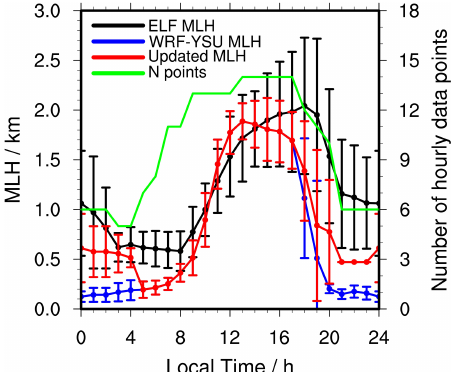
Figure 6. ELF-observed and model-simulated diurnal variations in MLH at the UMBC site during the Discover-AQ campaign. “ELF MLH” denotes ELF-derived MLHs by using the covariance wavelet transform method. “WRF-YSU MLH” denotes the 36km WRF- YSU k zz -determined MLHs, and “Updated MLH” denotes updated k zz -determined MLHs. See the main text for details. Vertical bars denote standard deviations. For the ELF MLHs, there are 13506 1min measurements in total during the campaign, and we bin them into hourly data. The green line corresponding to the right y axis shows the diurnal variations in the number of hourly ELF data